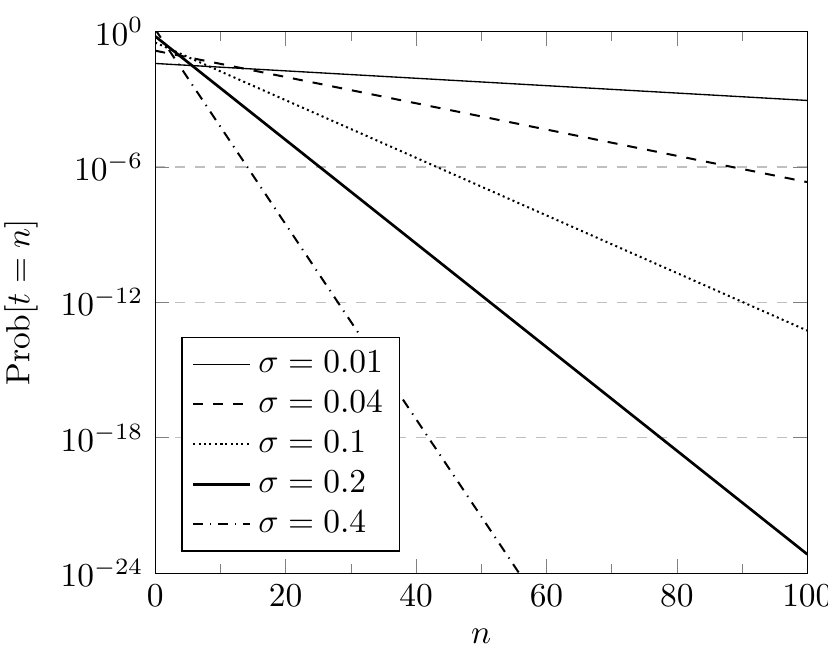
Figure 13. Tail distribution of the sojourn time Prob [ t = n ] versus n for Poisson service times with µ = 0.75, Poisson arrivals with λ = 1 and different values of σ .